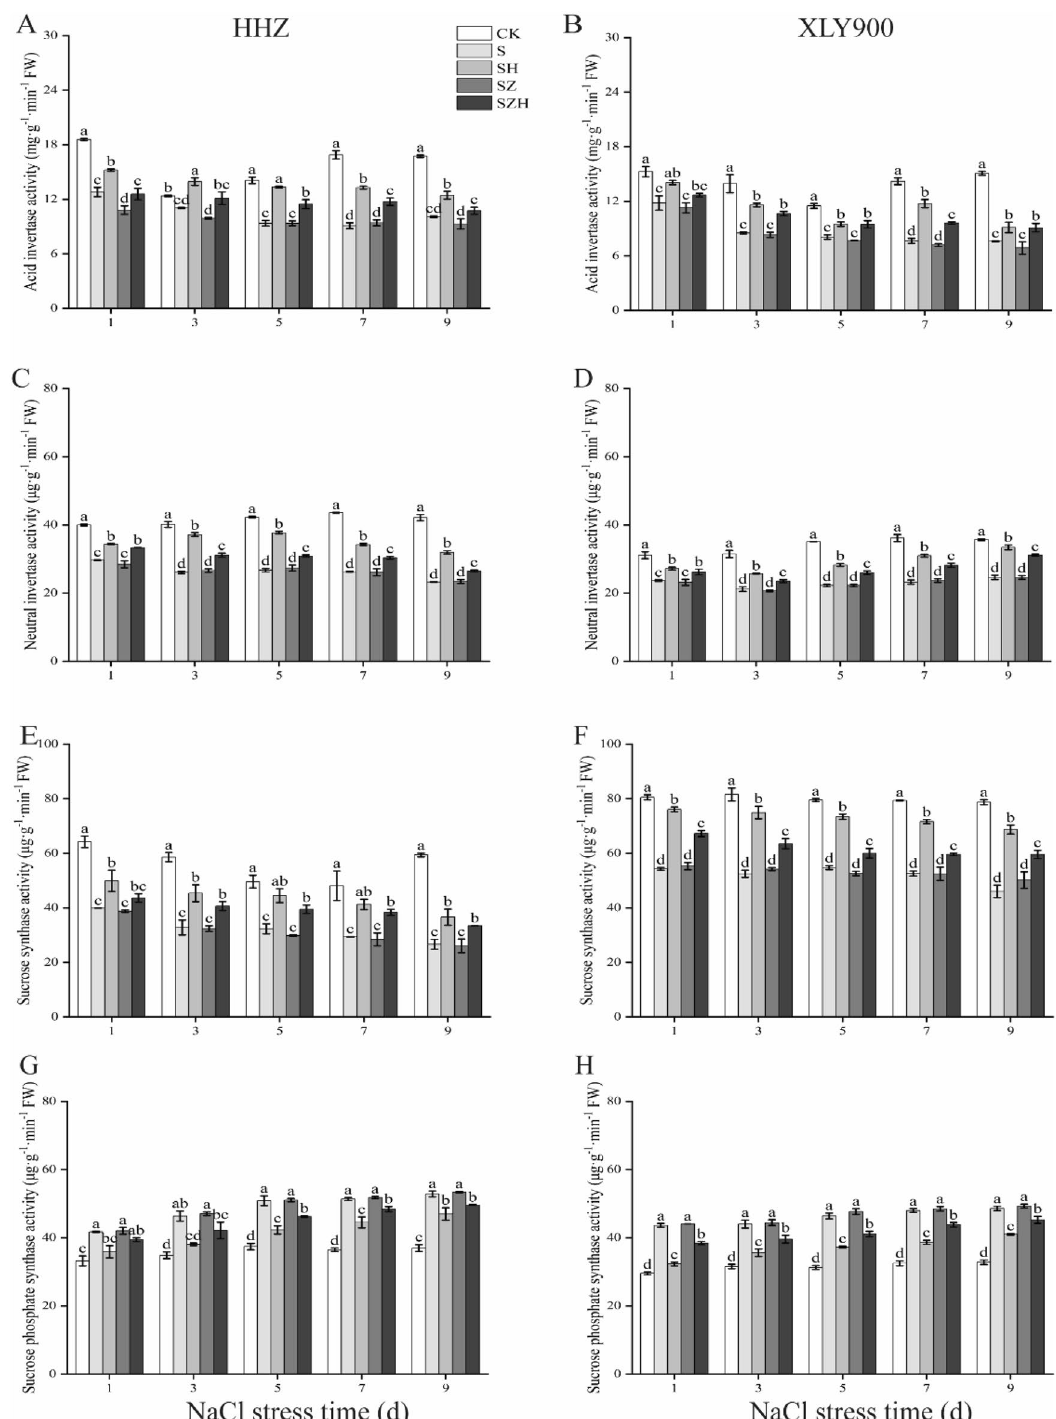
Figure 8. Effect of Hemin on sucrose metabolism related enzymes in rice under salt stress. acid invertase activity in HHZ ( A ) and XLY900 ( B ); neutral invertase activity in HHZ ( C ) and XLY900 ( D ); sucrose synthase activity in HHZ ( E ) and XLY900 ( F ); and sucrose phosphate synthase activity in HHZ ( G ) and XLY900 ( H ). CK: 0 mM NaCl + 0 μmol·L −1 Hemin, S: 50 mM NaCl + 0 μmol·L −1 Hemin, SH: 50 mM NaCl + 5 μmol·L −1 Hemin, the mean ± SD of three replicate samples. Different letters in the data column indicate significant differences (p < 0.05) according to Duncan’s